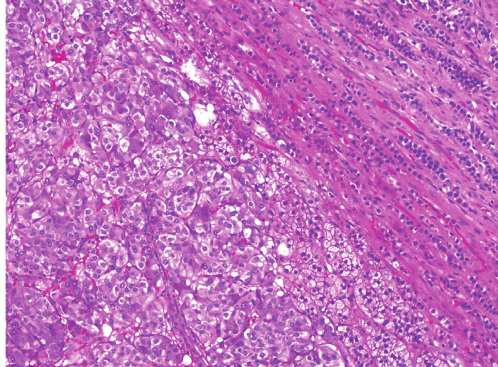
Figure 3: Histology demonstrates the well-circumscribed nature of the typical pheochromocytoma. There is an abrupt and distinct border between the pheochromocytoma on the left and the sur- rounding normal adrenal gland on the right. The tumor has the typical low-power architecture with cells arranged in nests and cords.